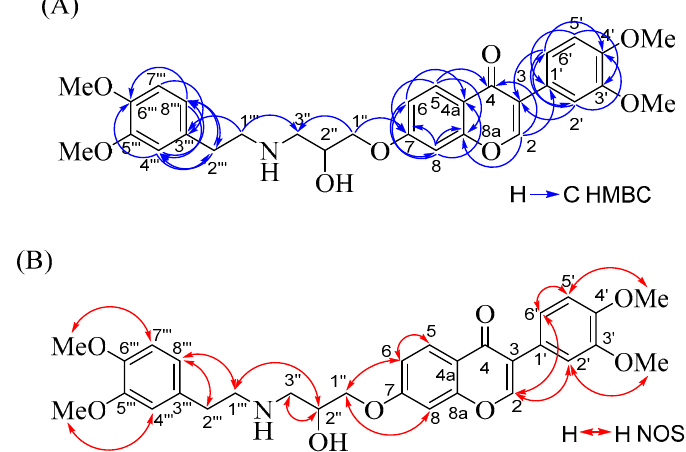
HMBC ( A ) and NOESY ( B ) correlations for 7-{3-[(3,4-dimethoxyphenethyl)amino]-2-hydroxypropoxy}-3-(3,4-dimethoxyphenyl)- 4H -chromen-4-one ( 6b ).